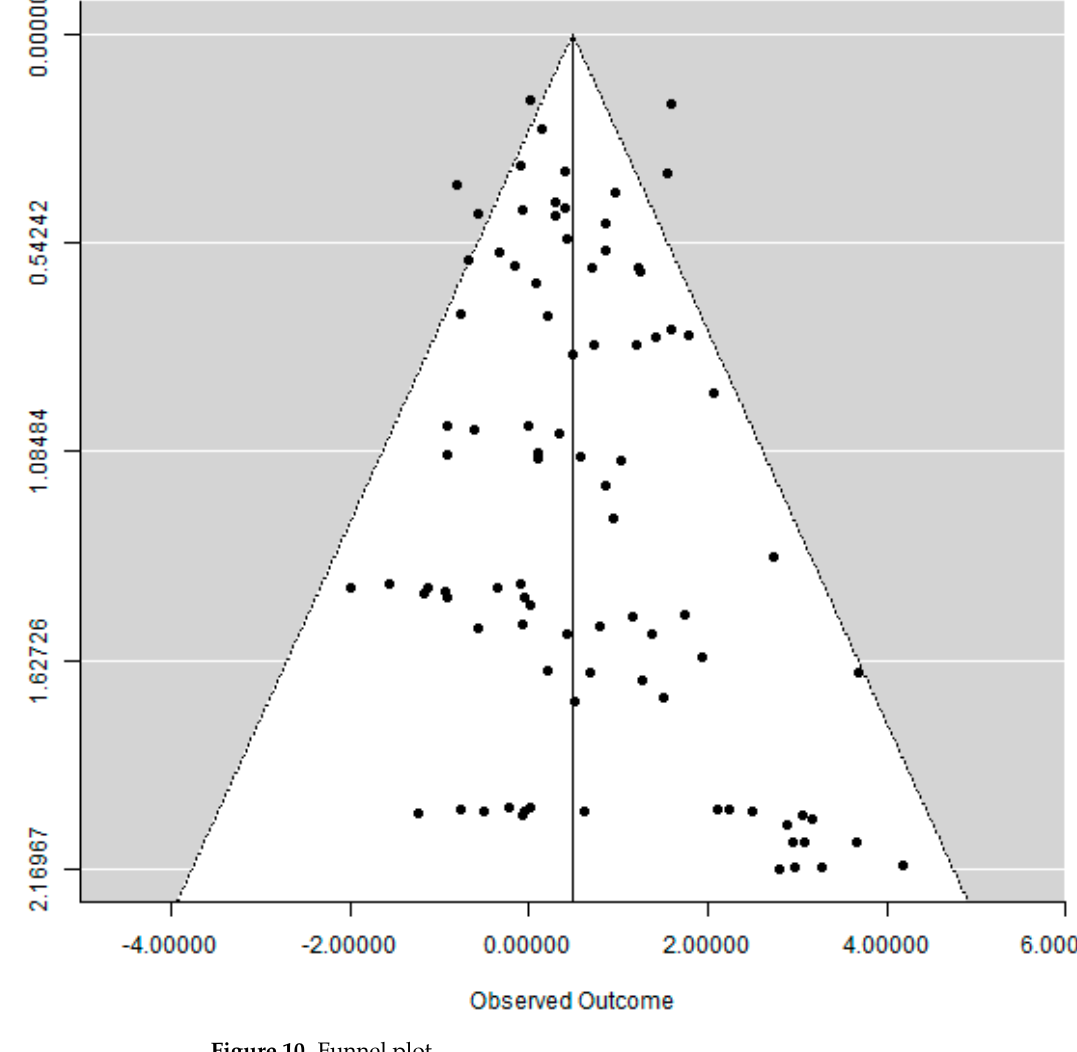
Figure 10. Funnel plot.